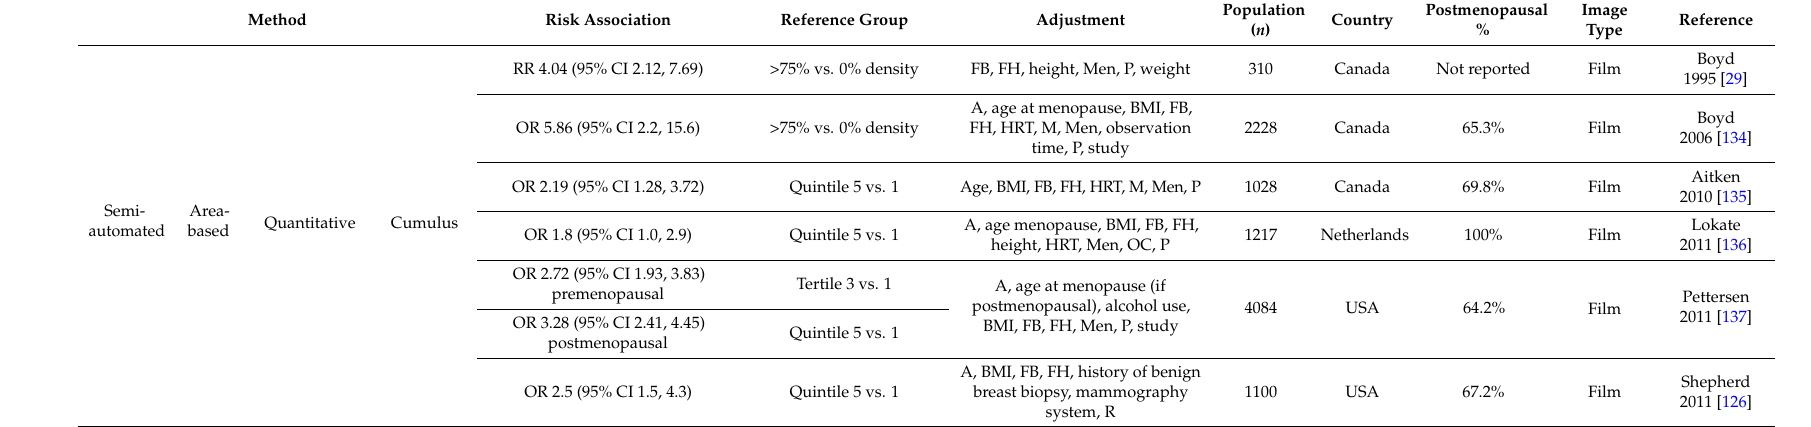
Table 4. Association of breast cancer risk with area-based methods of measuring